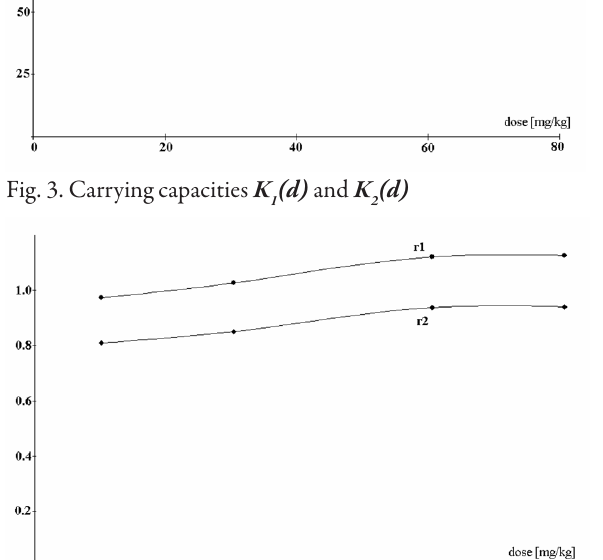
Fig. 6. Experimental data and simulation model for doses 10 and 60 mg/kg